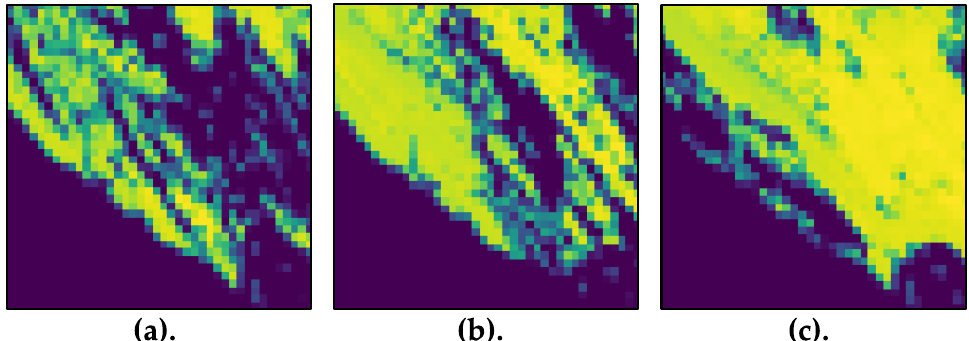
Figure 7. Downsampled FRP visualization samples at various times in Los Angeles, ( a ) March 2018, ( b ) June 2018, ( c ) August